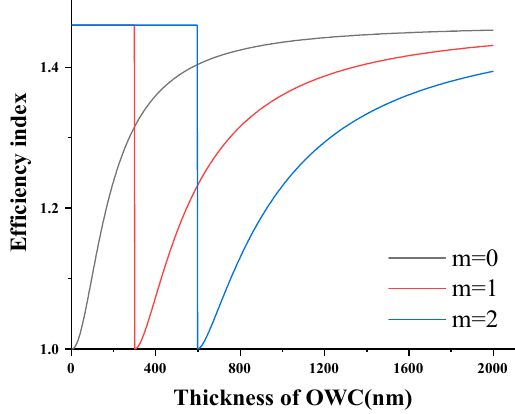
Figure 2. Effective index with the thickness of the optical cantilever. Figure 2. E ff ective index with the thickness of the optical